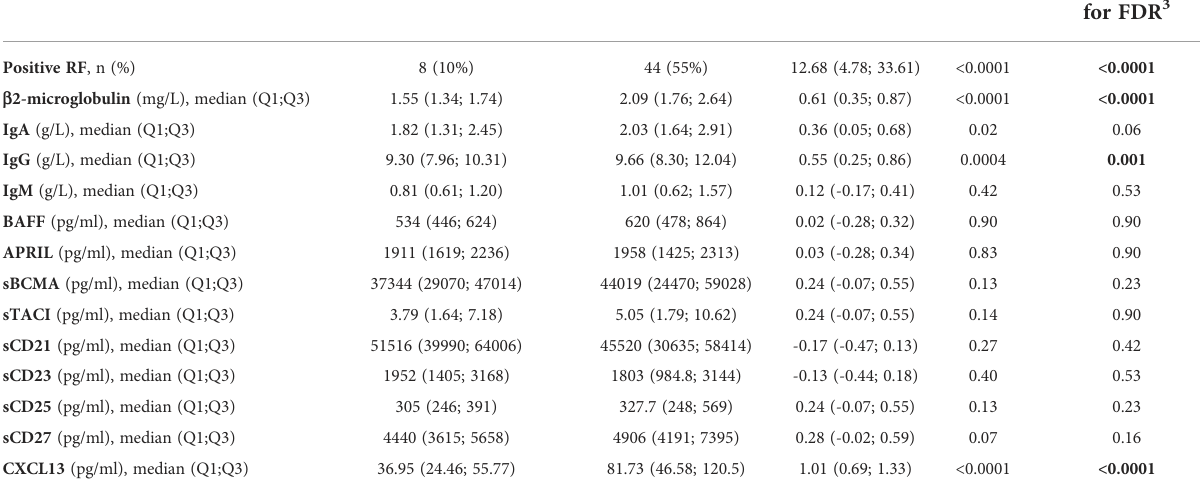
TABLE 2 Serum levels of soluble markers of B cell activation in the SSc patients and healthy controls (discovery cohort).